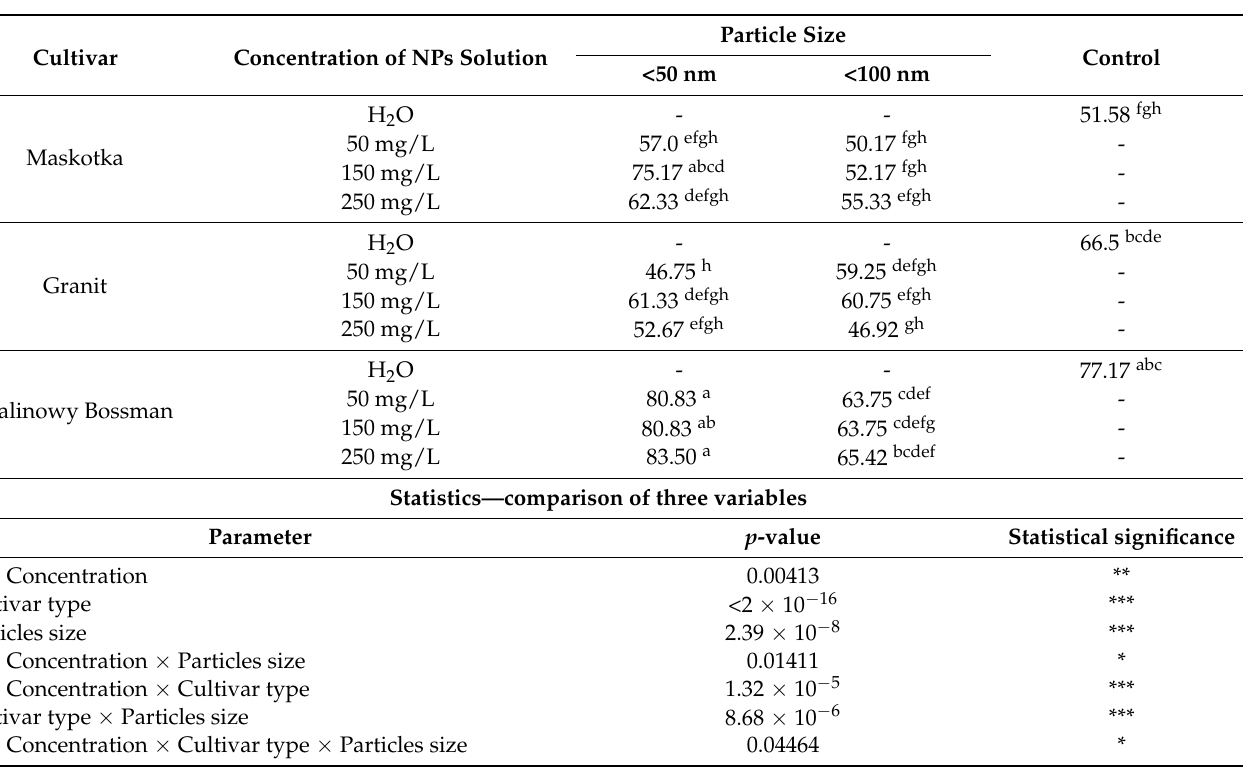
Table A2. The results of germination rate index (GRI) parameter obtained after treatment and statistic calculations. For this growth parameter, three variables were taken under consideration (NPs suspension, cultivar type, and the size of used NPs). In statistical part of the table, the statistical significance is expressed as “-”, which means that p -value was higher than 0.05 and certain parameters had no significant influence on the results; “*” means that p -value is lower than 0.05, “**” means that p -value is lower than 0.01, and “***” means that p -value is lower than 0.001. Small letters indicate the significant differences for p -value ≤ 0.05.